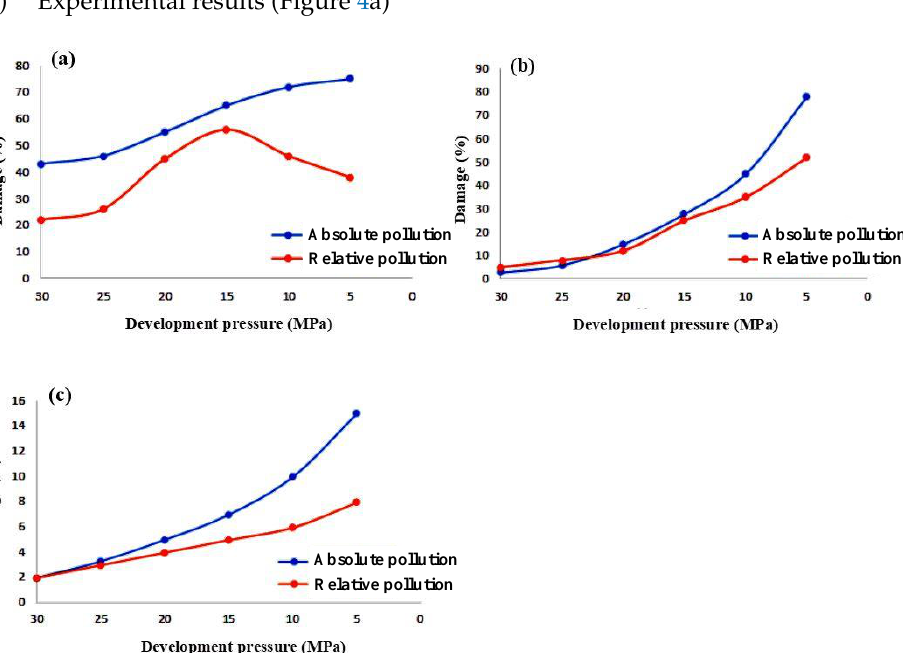
Figure 3. The core flooding experimental process.